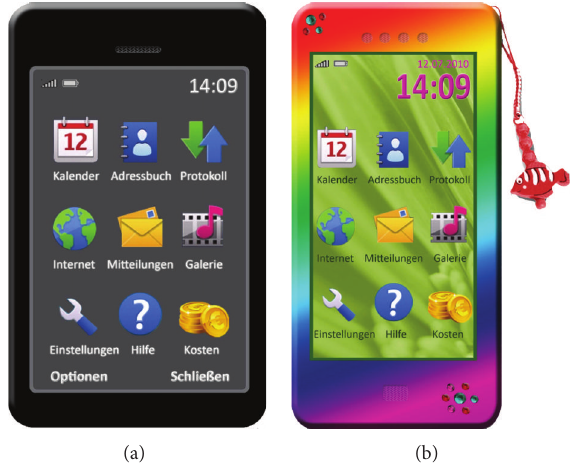
Figure 3: High (a) and low aesthetics design (b) of the mobile